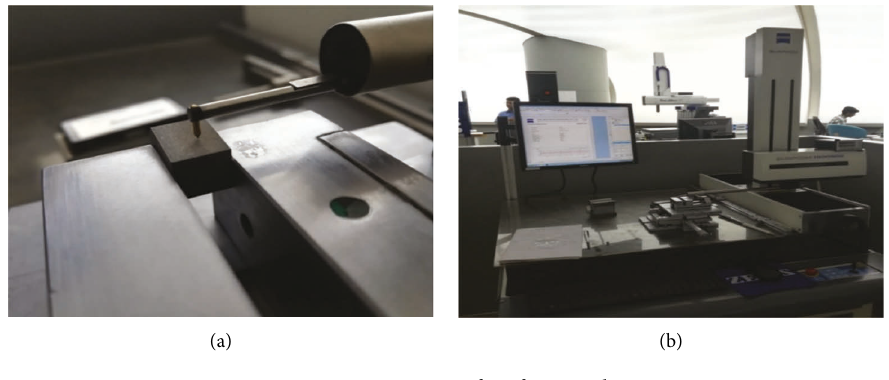
Figure 5: Measurement of surface